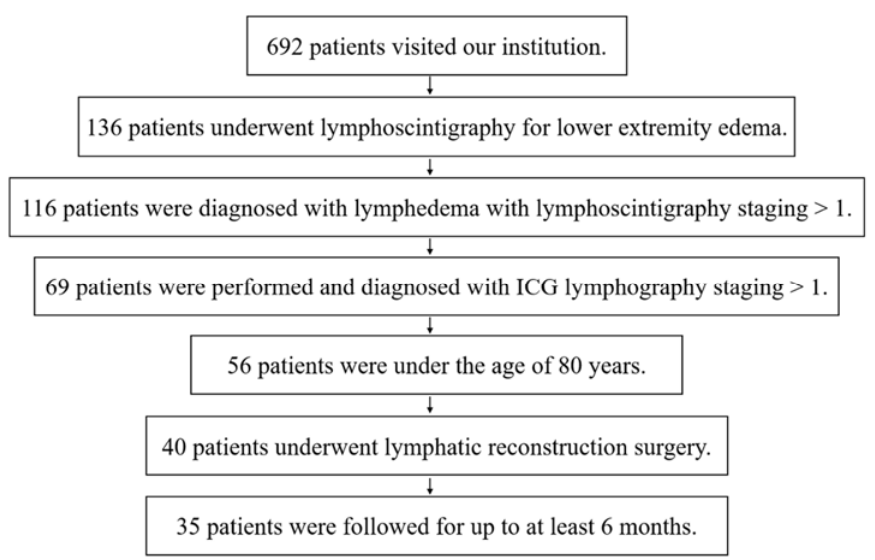
Figure 1. Flow chart of the selection and enrollment process of the patients in this study. ICG, indocyanine green.